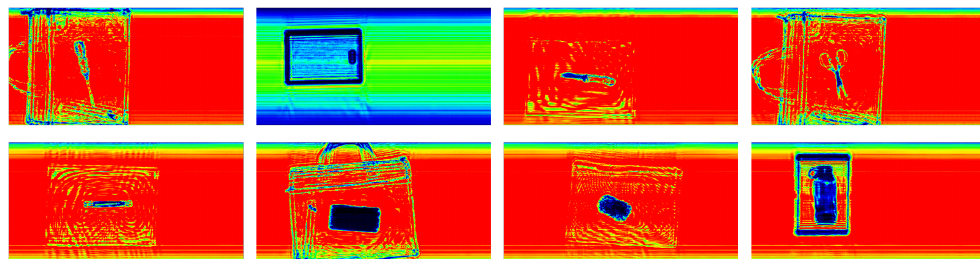
Figure 3. Terahertz acquisition image system and samples of hidden